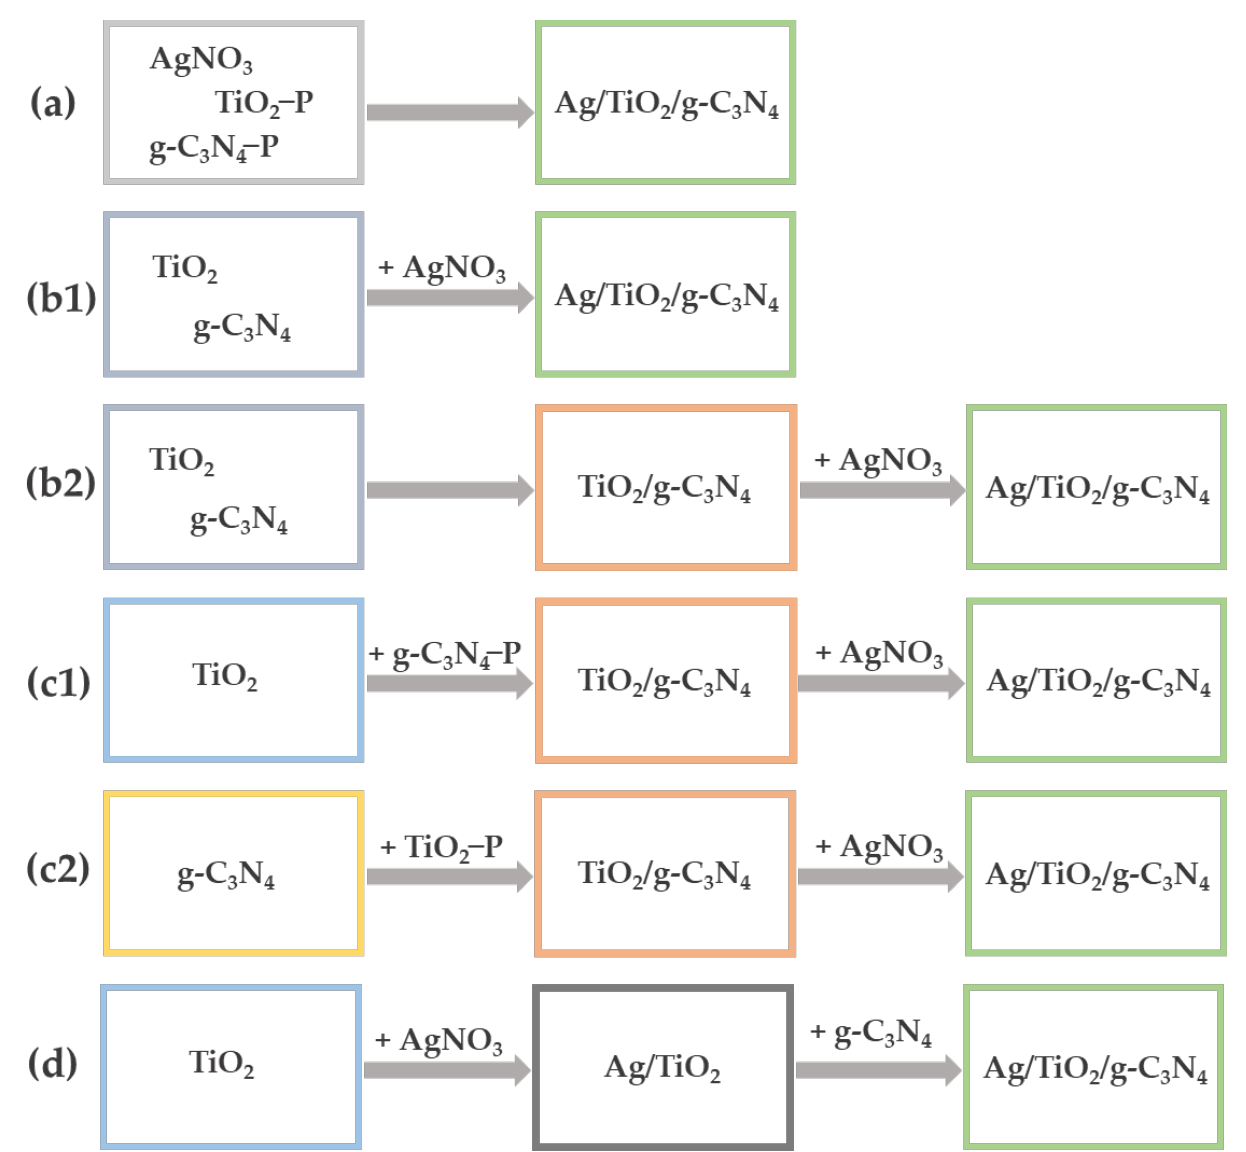
Figure 11. Schematic presentation of strategies for the synthesis of the Ag/TiO 2 /g-C 3 N 4 nanocomposites: synthesis of Ag/TiO 2 /melamine from a mixture of Ag, TiO 2 and g-C 3 N 4 precursors, followed by calcination to produce Ag/TiO 2 /g-C 3 N 4 ( a ); preparation of a mixture of TiO 2 and g-C 3 N 4 , followed by synthesis of Ag NPs ( b1 ); synthesis of TiO 2 /g-C 3 N 4 , followed by synthesis of Ag NPs ( b2 ); synthesis of g-C 3 N 4 in the presence of TiO 2 , followed by the synthesis of Ag NPs ( c1 ); synthesis of TiO 2 in the presence of g-C 3 N 4 , followed by the synthesis of Ag NPs ( c2 ); synthesis of Ag NPs in the presence of TiO 2 , followed by a mixture with g-C 3 N 4 ( d ). P =